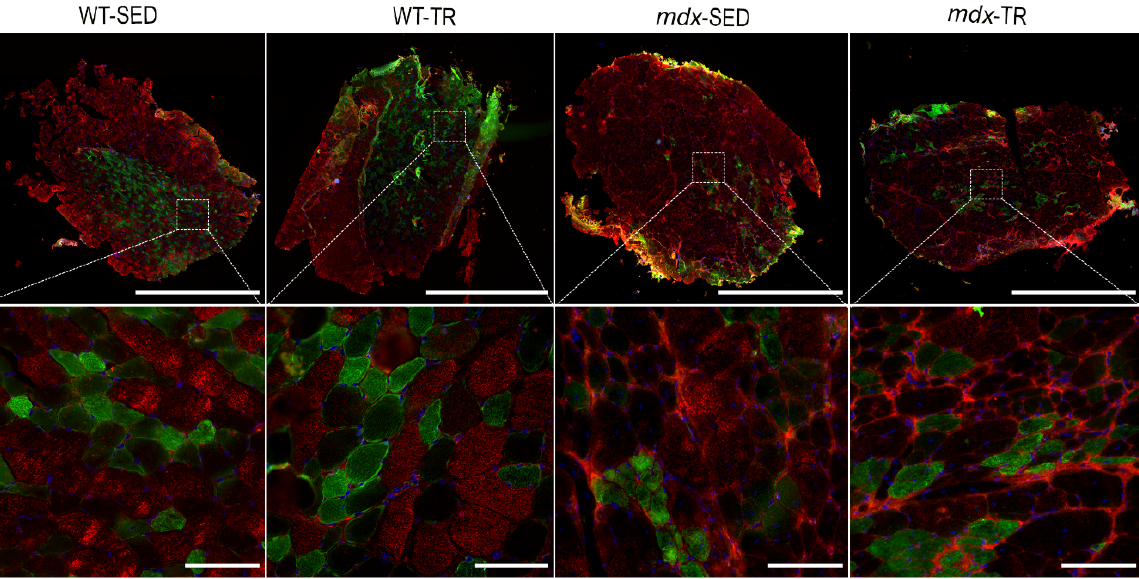
Figure 7. Representative images of immunostaining of different fiber types. MHC IIB (red, Cy5), nuclei (blue, DAPI), and MHC IIA (green, FITC) are shown. Images were obtained with the ImageX- press XLS System microscope at 4× magnification. Scale bar = 5000 µm (psoas muscle panels). All Zoomed areas at 40× magnification provided better visualization of the types of fibers in the psoas muscle (scale bar = 100 µm). Abbreviations: WT-SED: sedentary wildtype; WT-TR: trained wildtype; mdx -SED: sedentary mdx ; mdx -TR: trained mdx .